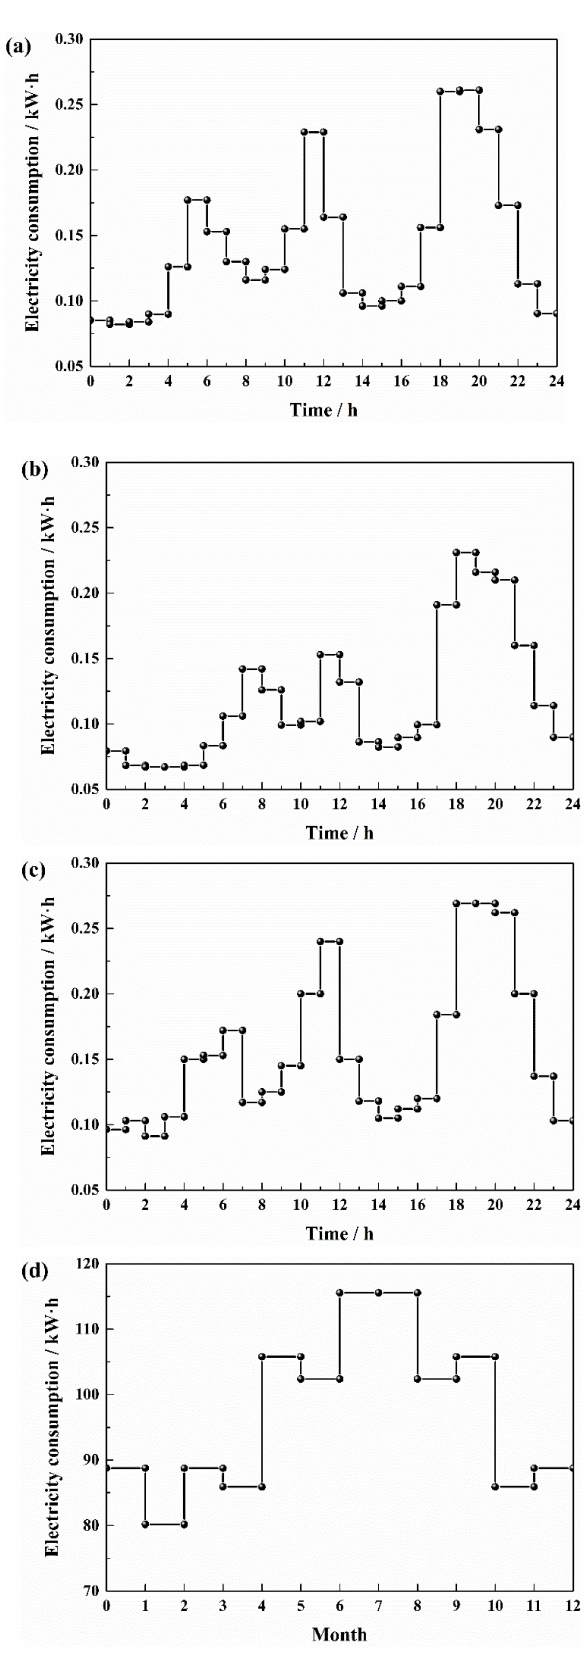
Figure 3. Electricity consumption: ( a ) Daily data of transition season; ( b ) Daily data of heating season; ( c ) Daily data of air conditioning season; ( d ) Monthly